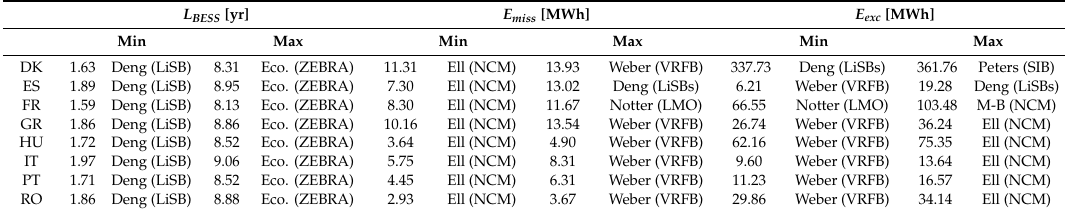
Table 9. Results of the modelling phase, minimum and maximum values, excluding the lifespan of